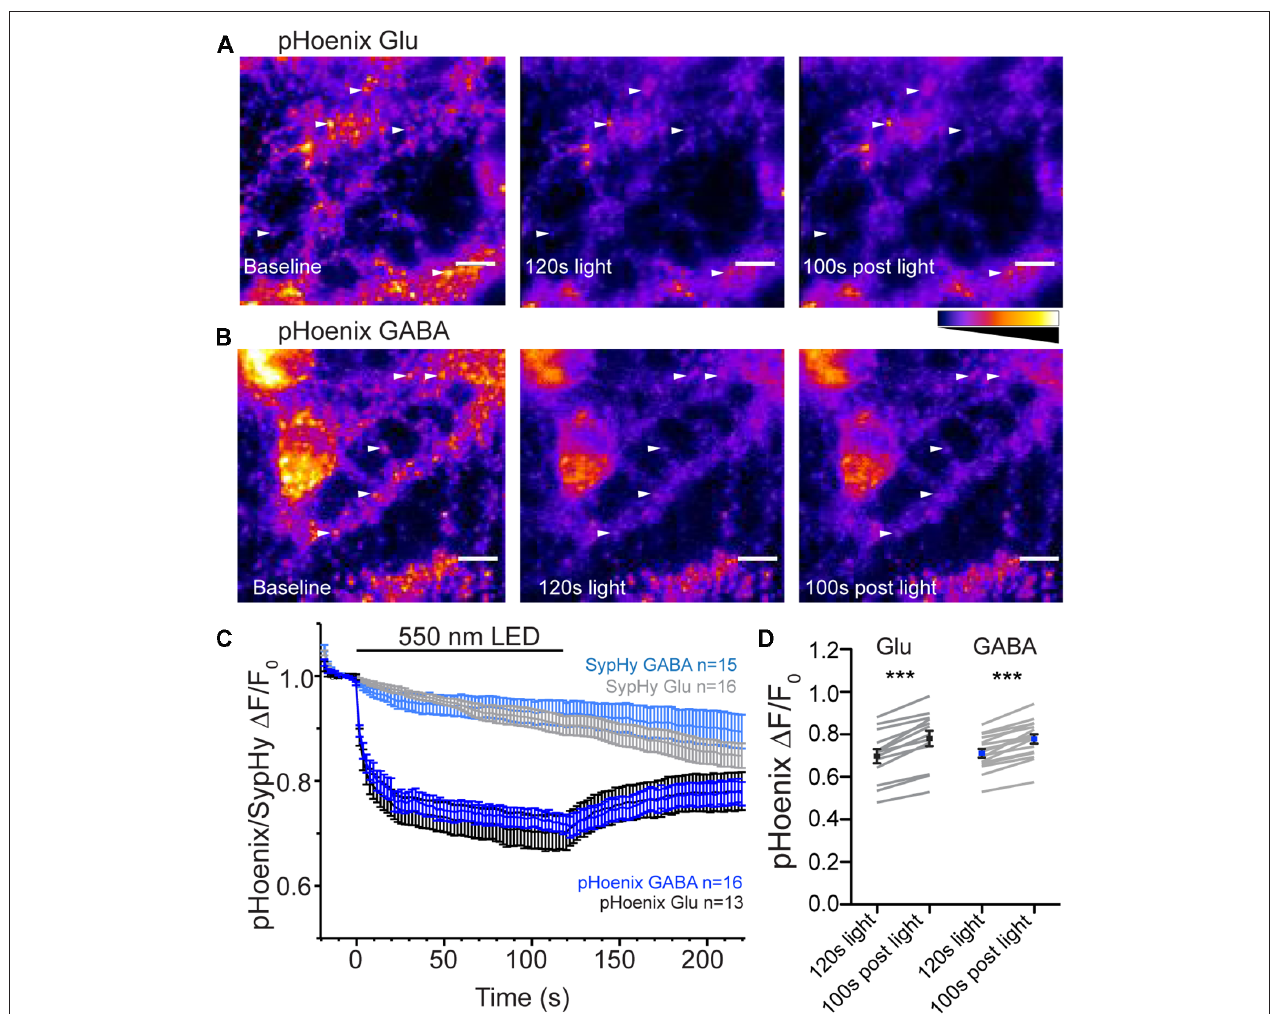
FIGURE 4 | pHoenix acidifies glutmatergic and GABAergic SVs in intact synapses. (A,B) Images of bafilomycin-treated (>2 h, 1 µ m) cultures expressing pHoenix in glutamatergic (A) or GABAergic (B) synapses at baseline, after activation of pHoenix with 550 nm LED for 120 s, and a time point 100 s after end of light stimulation. Image intensity scales for all panels were set to 0–1300 a.u. (A) or 0–700 a.u. (B) . Arrows indicate particular ROIs. Scale bar = 10 µ m. (C) Average fluorescence response normalized to baseline fluorescence in bafilomycin-treated cultures expressing pHoenix in glutamatergic (black; n = 13 images; three independent cultures) or GABAergic (blue; n = 16 images; three independent cultures) synapses or expressing only SypHy in glutamatergic (gray; n = 16 images; two independent cultures) or GABAergic (light blue; n = 15 images; two independent cultures) stimulated with 550 nm LED for 120 s. The SypHy-only images are included for control purposes and were performed in a separate set of experiments. (D) Comparison of pHoenix fluorescence normalized to baseline in bafilomycin-treated cultures at time points immediately after 120 s, 550 nm light stimulation and 100 s after completion of light stimulation in glutamatergic (black) and GABAergic (blue) synapses. Mean ± SEM. Significance determined by paired t -test. Glu ∗∗∗ p < 0.0001; GABA, ∗∗∗ p <